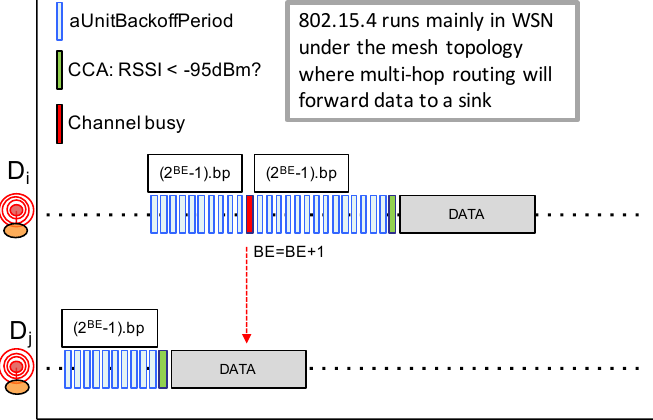
Figure 12. IEEE 802.15.4 non-beacon unslotted